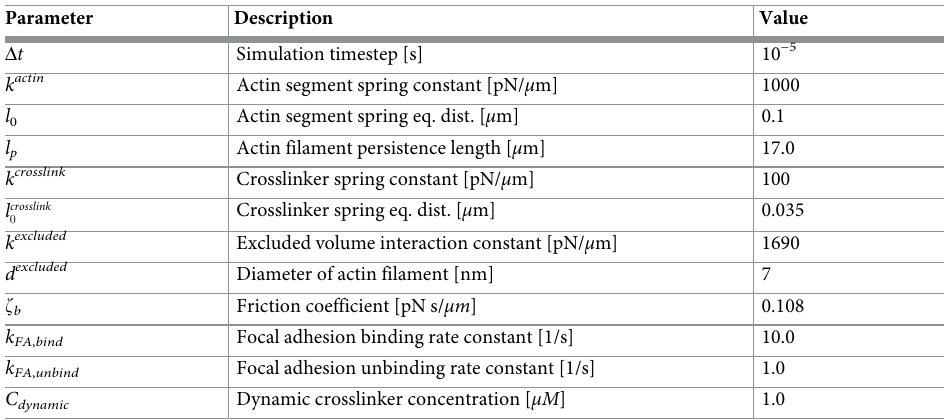
Table 1. Simulation reference parameter